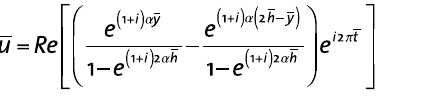
Figure 5 (above): (a) Calculated velocity pro- files at different time slices t– = [0, p /6, p /3, p /2, 2 p /3, 5 p /6, p ], t– (b) velocity profiles at = p /2 ofh– for different values = 0.5, = b = b 1.0, ∞. In (a) - (b): b 1 2 4 = b = 0.1 5 (solid: present model; dotted: Newtonian fluid). Figure 6 (below): (a) Calculated velocity pro- files at different time slices t– = [0, p /6, p /3, p /2, 2 p /3, = 0.5, (b) time 5 p /6, p ], b 1 series of the velocity profiles y– at = 0.25 (the middle of the = 0.1, 0.5, 1.0. channel), b 1 In (a) - (b): b = b = b = 0.1 2 4 5 (solid: present model; dotted: Newtonian